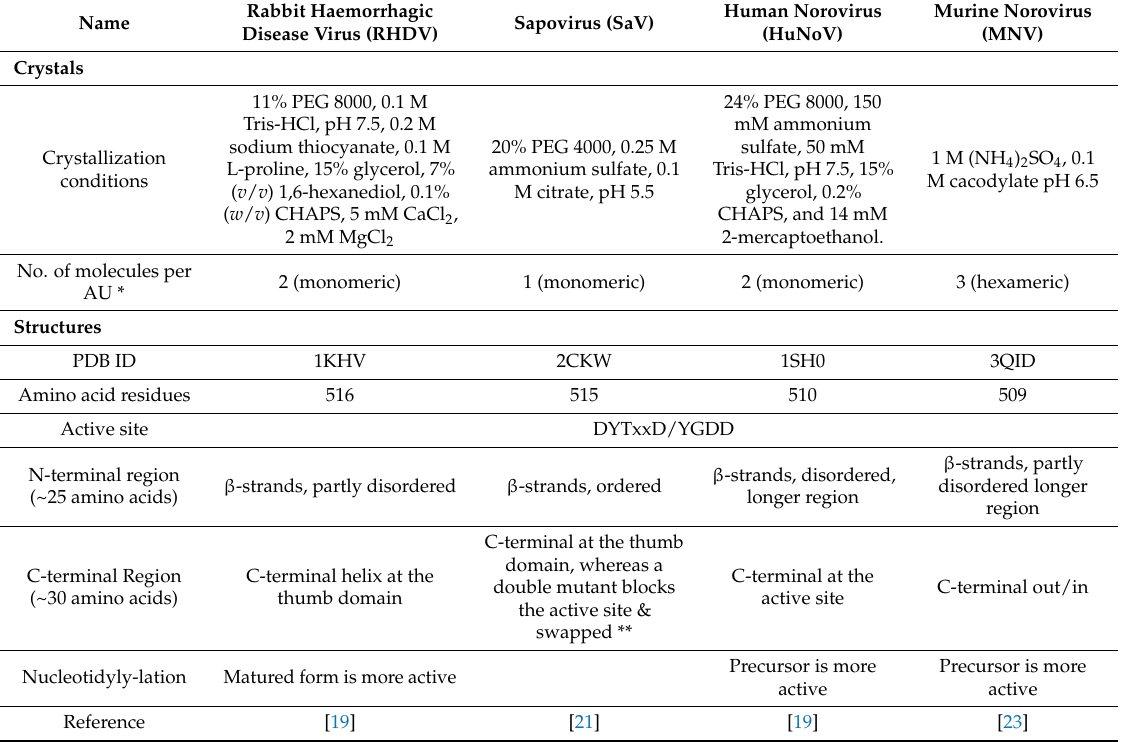
Table 1. Calicivirus RNA-dependent RNA polymerase (RdRp)